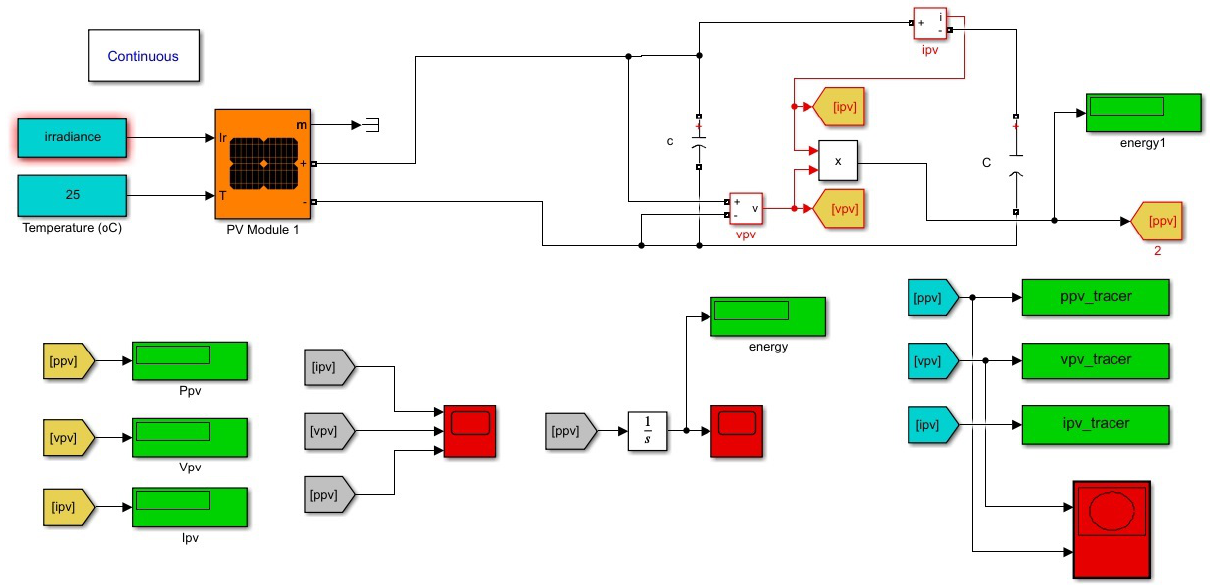
Figure 11. Simulink model of curve tracer for MLPE distributed PV